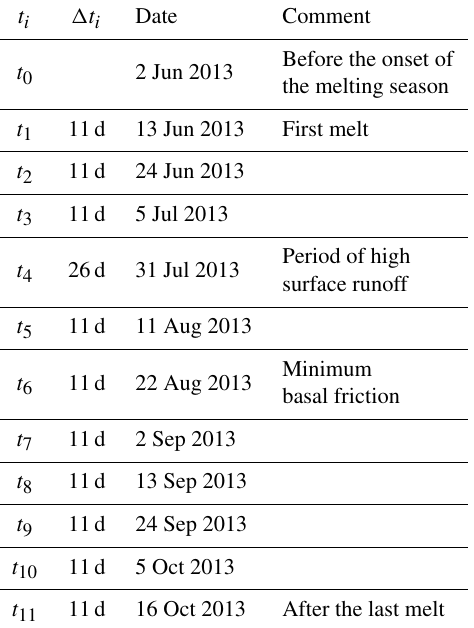
Table 1. Observation times of velocity acquisitions, t i , associated dates and time interval between two observations ( (cid:49)t i ). The Hi- DEM model is run for observational times t 0 , t 4 , t 6 and t 11 indi-